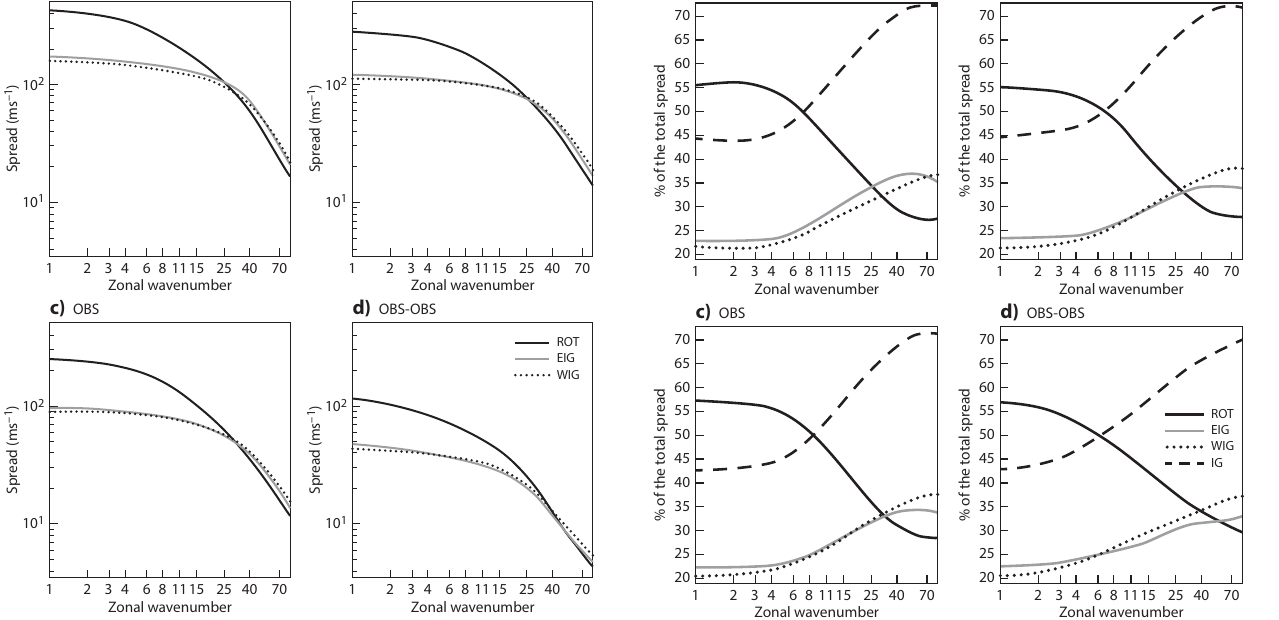
Figure 8. Ratios of the balanced (ROT), EIG, WIG and IG (EIG+WIG) spread to the total spread in each zonal wave num- ber for (a) XB-EDA , (b) ST-EDA , (c) OBS-EDA and (d) OBS-OBS- EDA . The ratios are multiplied by 100. Black curves correspond to balanced modes (ROT), grey to easterly propagating inertia- gravity modes (EIG), dotted to westerly propagating inertia-gravity (WIG) while dashed curves correspond to all inertia-gravity modes